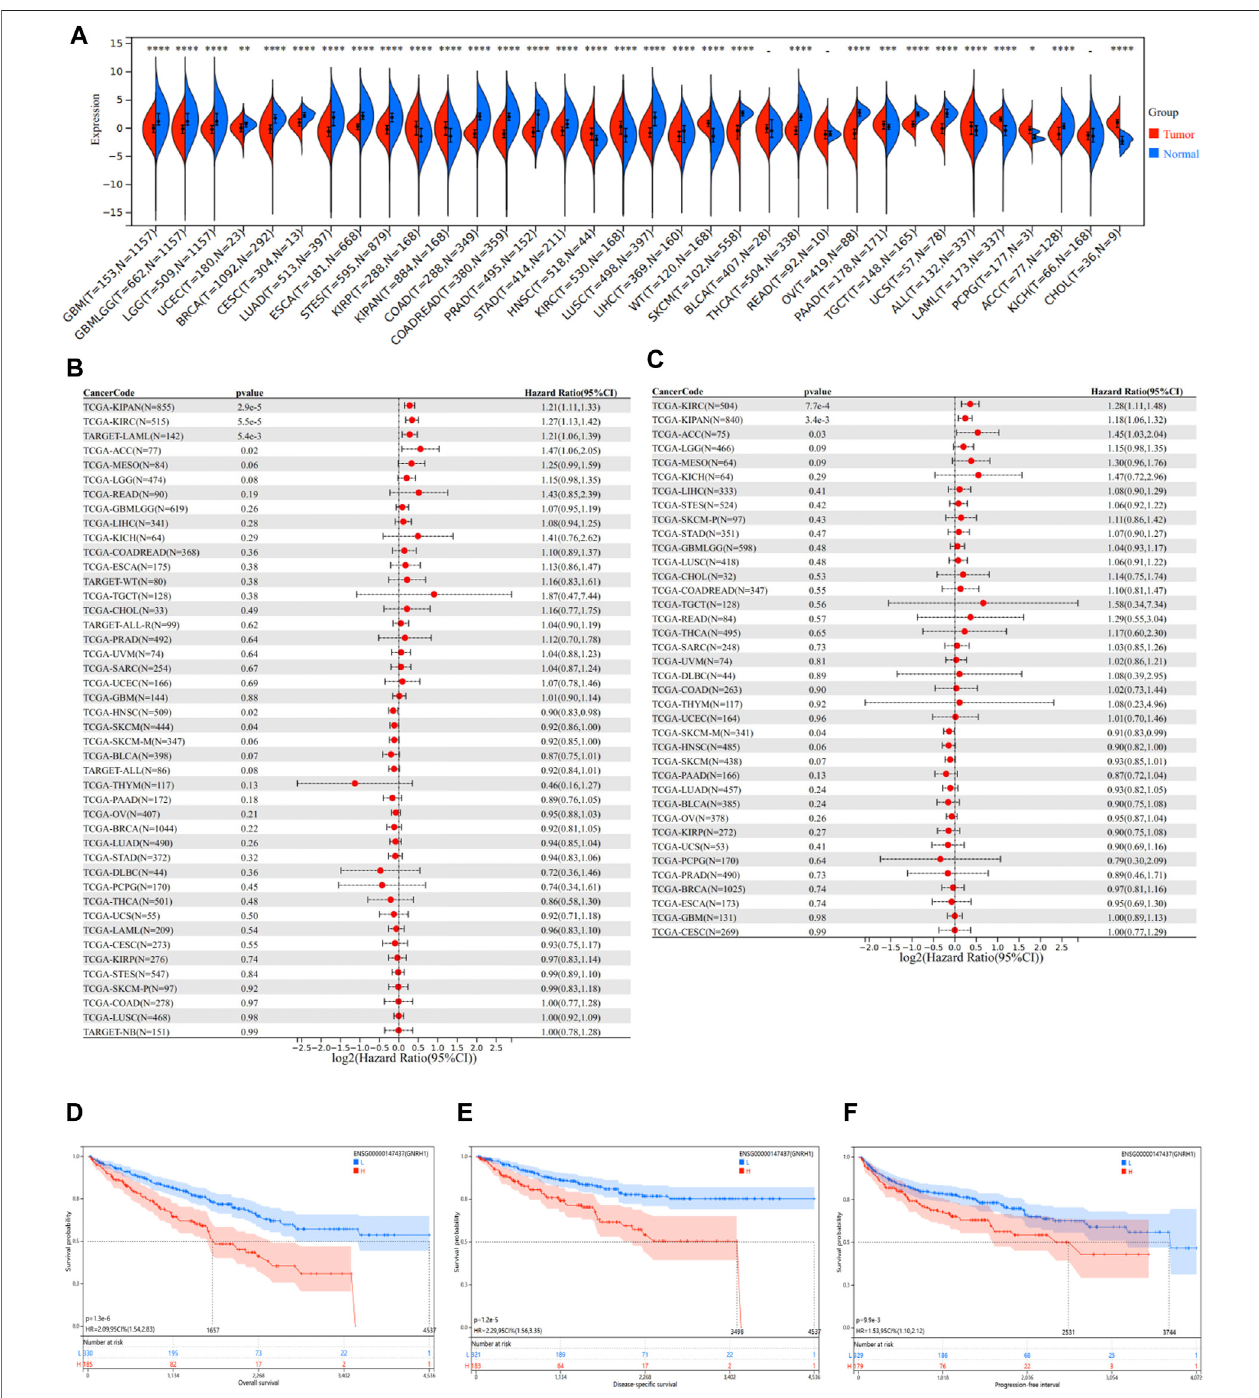
FIGURE 7 | Pan-cancer analysis of GNRH1. (A) Expression status of the GNRH1 gene in 34 different cancers and the corresponding normal tissues. (B) Correlation between GNRH1 expression and overall survival of different tumors. (C) Correlation between GNRH1 expression and disease-speci fi c survival of different tumors. (D – F) Kaplan – Meier curves of OS, DSS, and PFS strati fi ed by the low- and high-expression of GNRH1 in TCGA-KIRC.